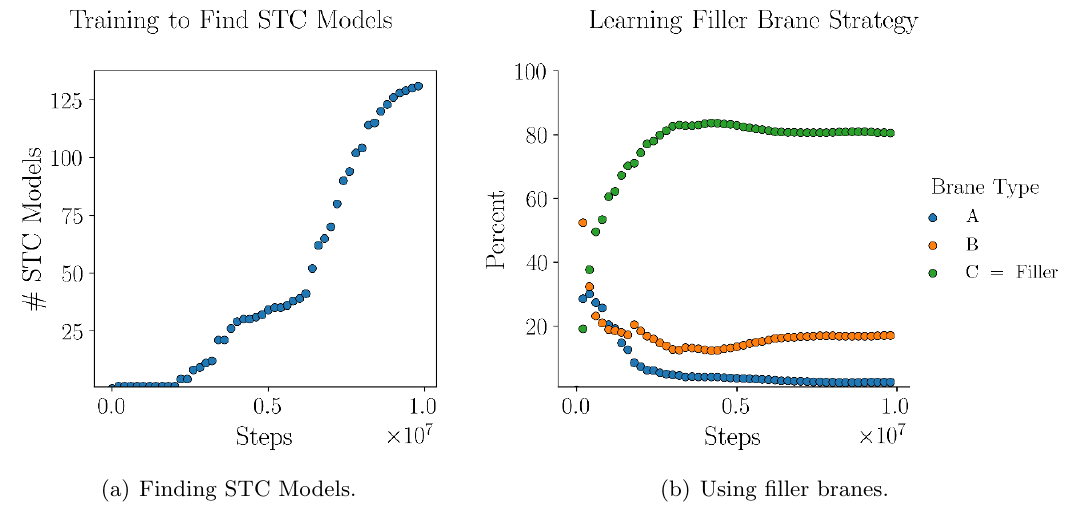
Figure 5 . RL learning a human-derived strategy to solve SUSY and tadpole